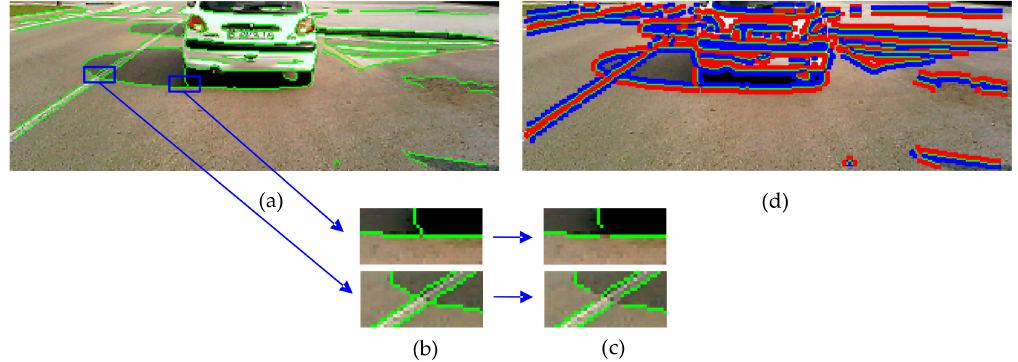
Figure 9. ( a ) Canny edge map (in green) overlaid on the ROI of an incoming image of our dataset. ( b ) Two examples of T-junction connecting di ff erent edges. ( c ) Individual edges after removing T-junctions. ( d ) Brighter (in red) and darker (in blue) regions across edges (in green) after T- and X-junction